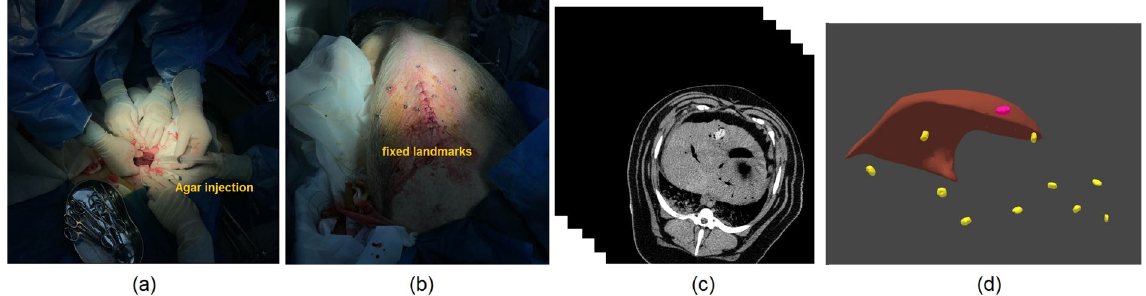
Fig. 5 Animal experiment setting and 3D reconstruction results. (a) Tumor implantation using agar. (b) Metal landmark placement. (c) CT imaging. (d) 3D reconstruction of liver, tumor, and 10 metal landmarks.